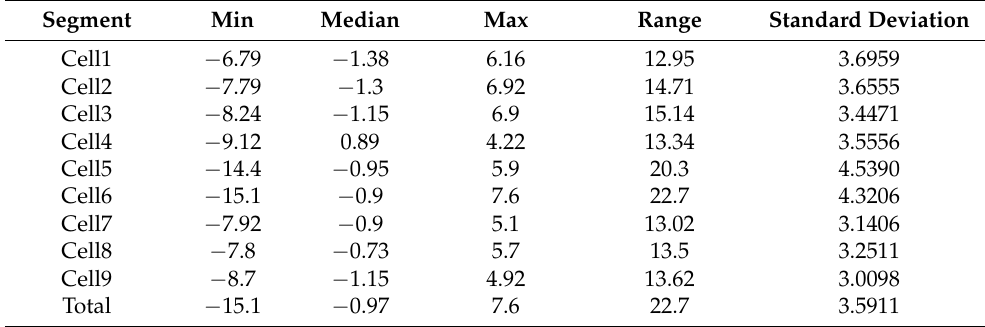
Table 11. Uncontrolled time speed